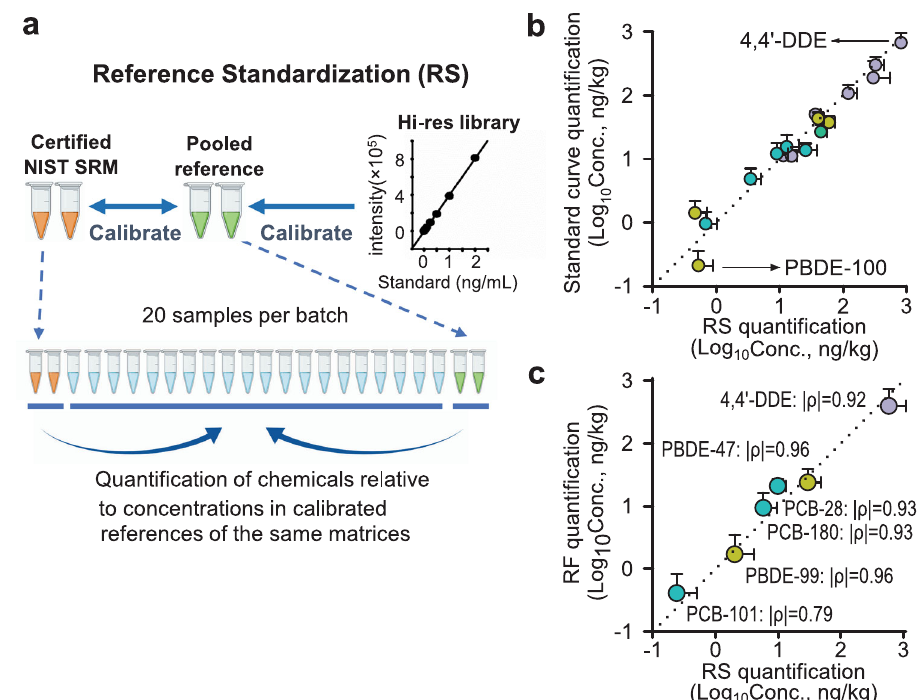
Fig. 3 Adaptation of reference standardization to GC – HRMS provides automated work fl ow for quanti fi cation of identi fi ed environmental chemicals. a Reference standardization (RS) is a validated single-point quanti fi cation method used in liquid chromatography – high-resolution mass spectrometry (LC – HRMS) for automated measurement in high-throughput analyses. The method relies upon pooled reference materials that are calibrated relative to external calibration curves and relative to other pooled reference materials. These pooled reference materials are analyzed before and after each batch of samples, so that concentrations of environmental chemicals detected in the samples can be quanti fi ed relative to concentrations in the pooled reference materials, which may be validated by external calibration with high-resolution (Hi-res) chemical library. b We used dilution series of environmental chemical standards to validate quanti fi cation by reference standardization; mean concentrations of plasma samples ( n = 20 biologically independent samples) are presented with positive SEM by two methods. c We determined response factors (RF) using stable isotopes to validate quanti fi cation by reference standardization; mean concentrations of lung samples ( n = 11 biologically independent samples) are presented with positive SEM by two methods. Spearman ’ s correlation | ρ | was presented. DDE dichlorodiphenyldichloroethylene, PBDE polybrominated diphenyl ethers, PCB polychlorinated biphenyls. Pesticides are colored in purple, with polychlorinated biphenyls (PCBs) in teal, and polybrominated diphenyl ethers (PBDEs) and polybrominated biphenyl (PBB) in yellow-green. Source data are provided as a Source Data fi